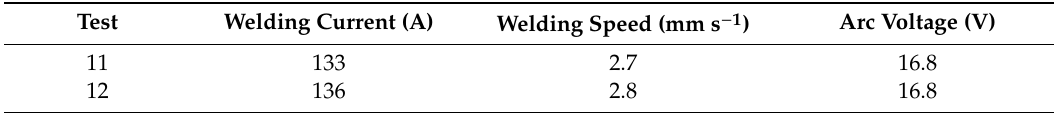
Table 7. Validation welding